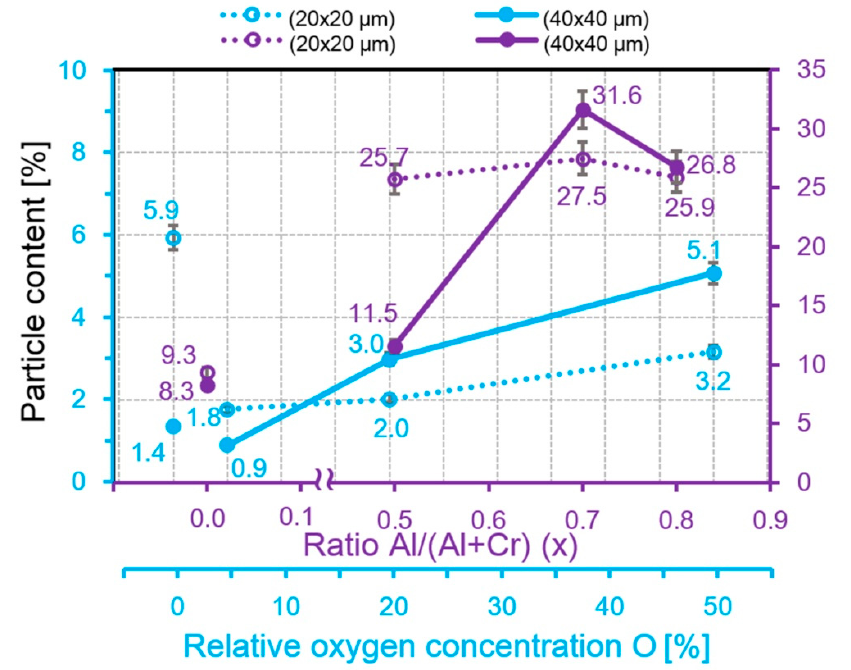
Figure 6. The dependences of the particle content from the addition content in the CrN coatings.